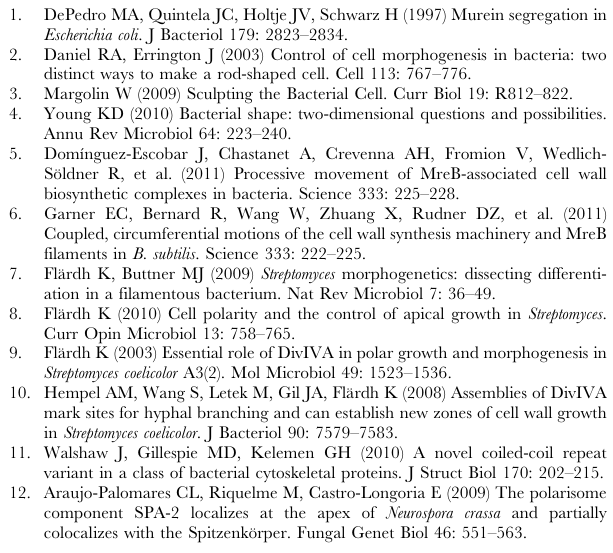
splitting, growth of foci and emergence of branches, in fluorescence-imaged Streptomyces coelicolor expressing divIVA-egfp . Time in hours:minutes:seconds. (MOV) Video S2 Movie version of Figure 3. Example of branching at almost zero distance from the tip. Time in hours:minutes:seconds. (MOV) Video S3 Example of the full model simulation output, showing Streptomyces starting from a spore and growing for about fourteen hours. Hyphae in green; DivIVA foci in red. (GIF) Video S4 Large-scale example of the full model simulation output, showing Streptomyces starting from a spore and growing for about eleven hours. Hyphae in green; DivIVA foci in red; cross- walls in yellow. (GIF) Video S5 Large-scale example of the full model simulation output with 25-fold overexpression of DivIVA. Simulation lasts for about seven hours with overexpression occurring after 14,000 s. Hyphae in green; DivIVA foci in red; cross-walls in